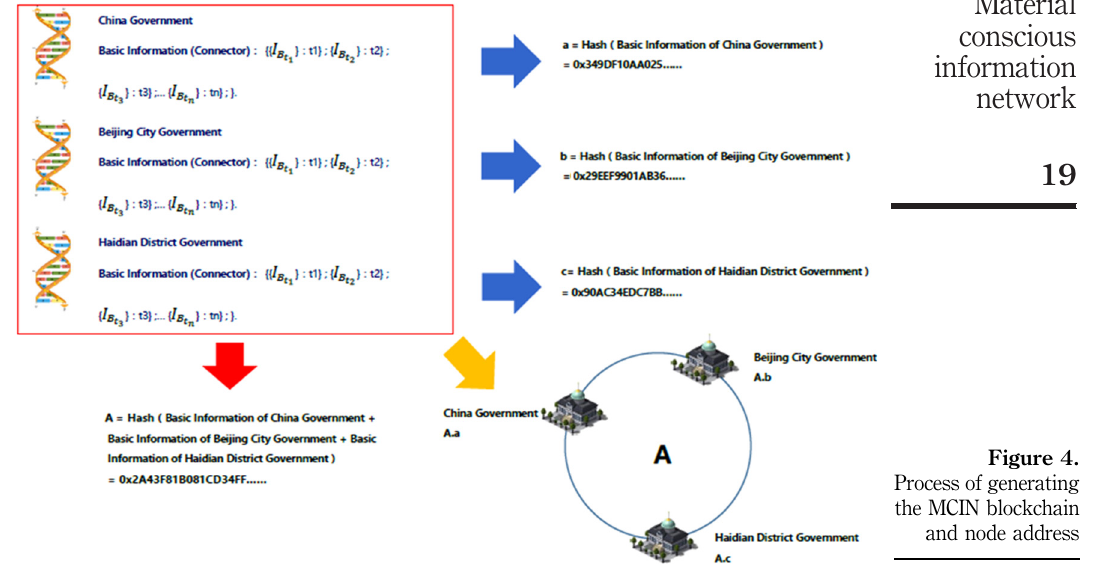
Figure 4. Process of